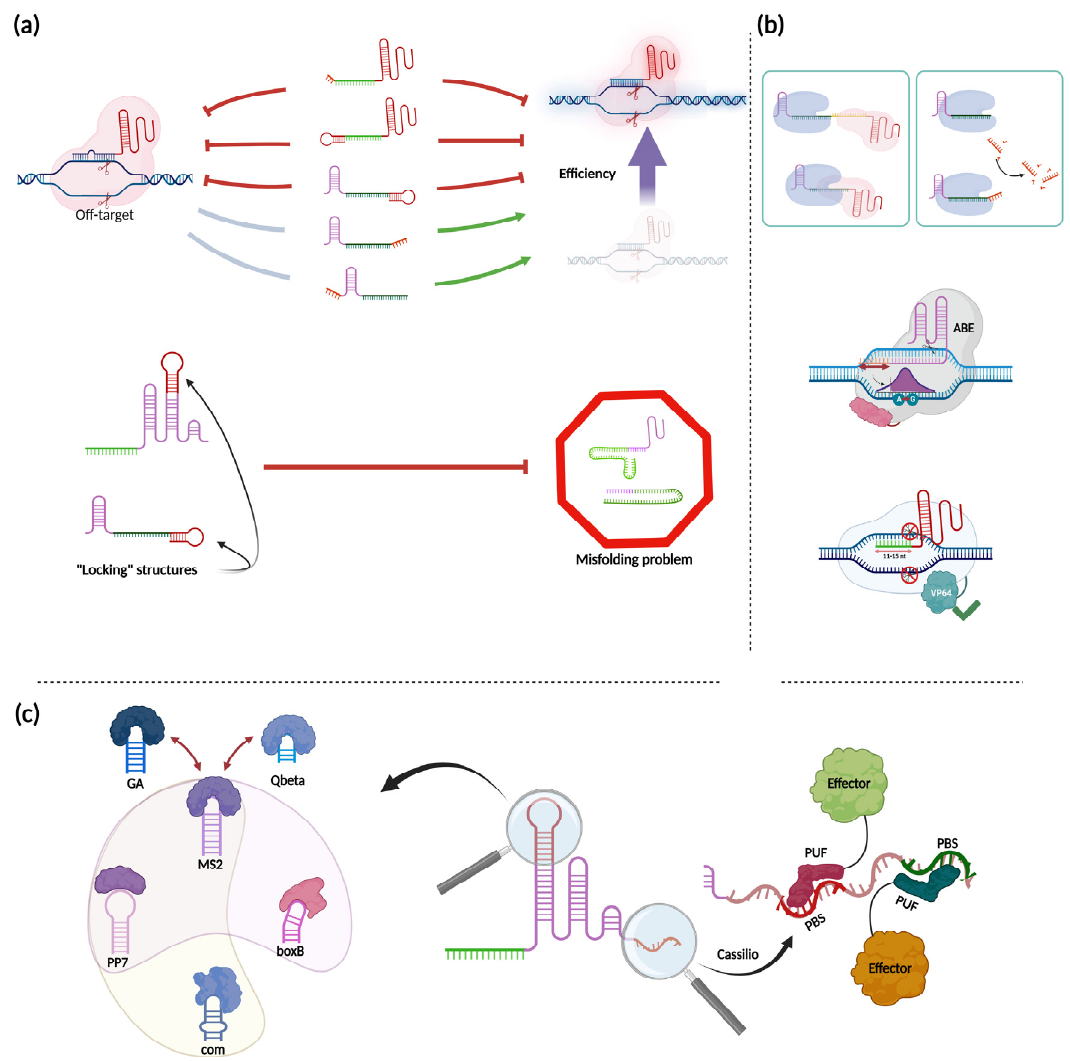
Figure 4. gRNA modifications. ( a ) Impact of sgRNA and crRNA modifications on OFF-target activity and editing efficiency. Adding hairpin structures or small flaps to the end of gRNAs results in different outcomes for Cas12a- and Cas9-based systems. Red inhibitory lines depict the antagonism between different modifications and the OFF-target effect or editing efficiency. Green arrows depict the opposite. Gray lines mark modifications that do not have any effect on specificity. The bottom scheme depicts the approach to block misfolding of impaired gRNA by introducing a “locking” structure inside their sequences; ( b ) Different functional consequences of gRNA sequence modifications. Upper left: a shared usage of single gRNA by Cas12a and Cas9. Upper right: an enhancement of trans-cleavage activity of Cas12a used in pair with elongated crRNA. Middle: restriction of the modification window for the Cas9 base-editor ABE for spacers truncated to 19 nts or elongated to a length of more than 24 nts. Bottom: a decrease in the length of sgRNA to 15 nts or fewer (but not less than 11 nts) completely eliminated the ability of Cas9 to cleave DNA while retaining the ability to bind recognition sites and to activate thereby adjacent genes; ( c ) Implementing sequence augmentations and aptamers. On the left side, different RNA aptamers are depicted. Dark red arrows indicate interchangeability between aptamer binding proteins. Transparent colored clouds depict examples of non-overlapping multiple usage of different aptamers inside shared synthetic systems. The right side depicts a part of the Cassilio system, with effectors fused with PUF-domains, specifically programmed to bind different PBS (PUF-binding site). Figure was created using BioRender.com.